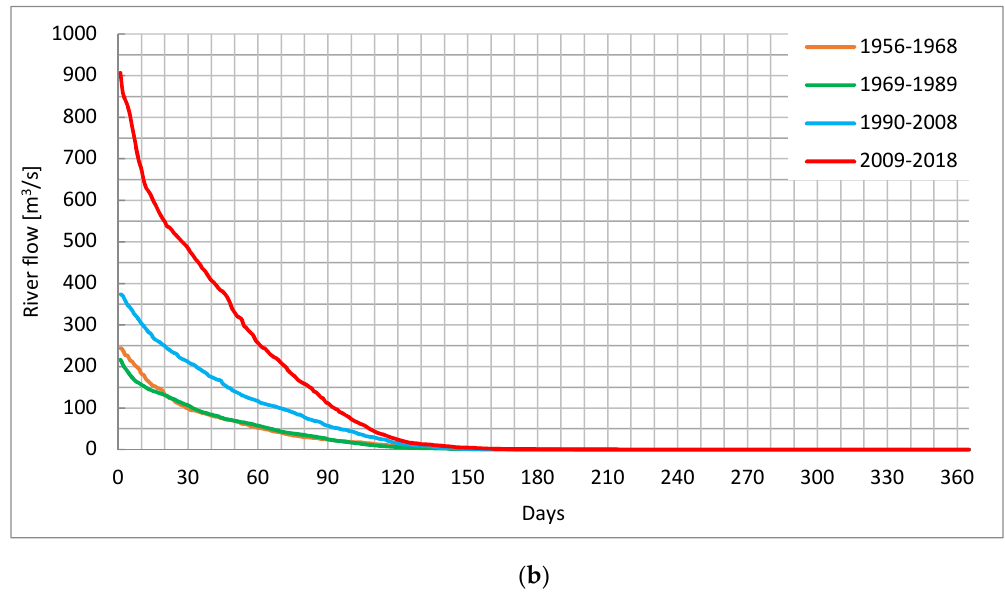
Figure 7. ( a ) The evolution of the FDC over time; ( b ) flow duration curves for the different periods, from one changepoint to the next.